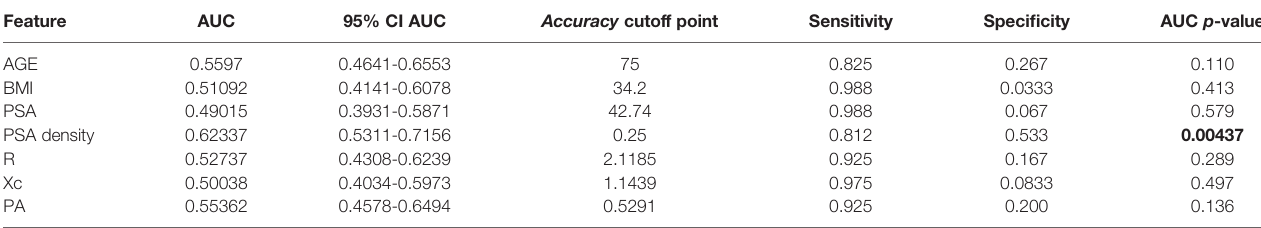
TABLE 7 | Statistical analysis for each feature.